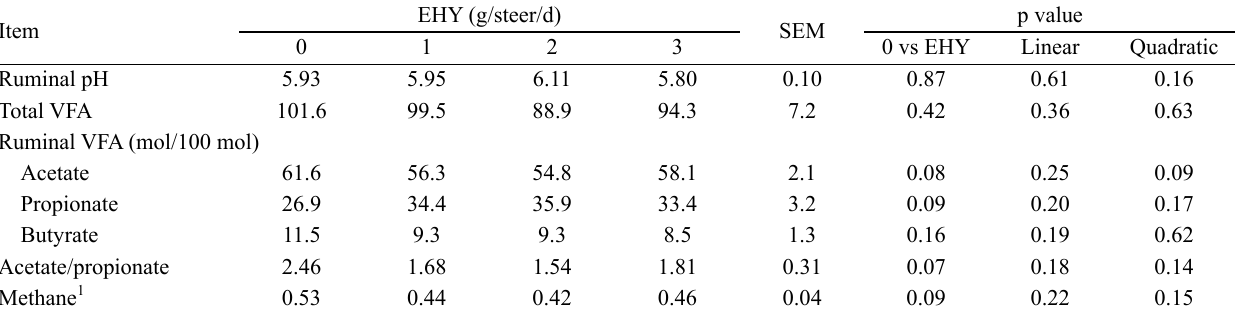
Table 5. Influence of enzymatically hydrolyzed yeast (EHY) supplementation on characteristics of ruminal fermentation EHY (g/steer/d) Item